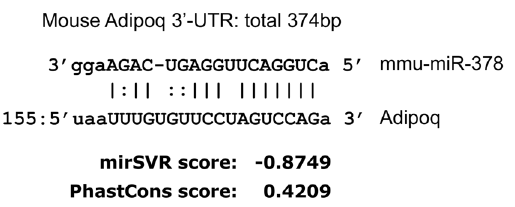
Figure 1. Prediction of miRNA-378 targets insilico . The miRNA- 378 targets were predicted using Targetscan (www.targetscan.org)